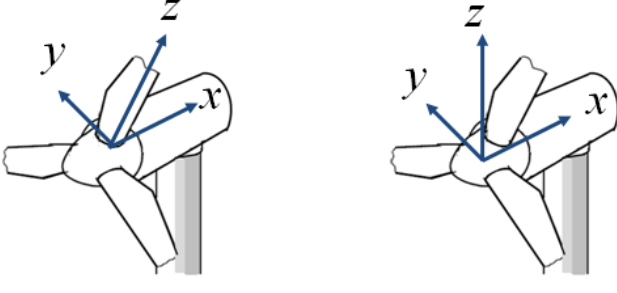
Figure 1. ( a ) Blade coordinate system; ( b ) Fixed hub coordinate system